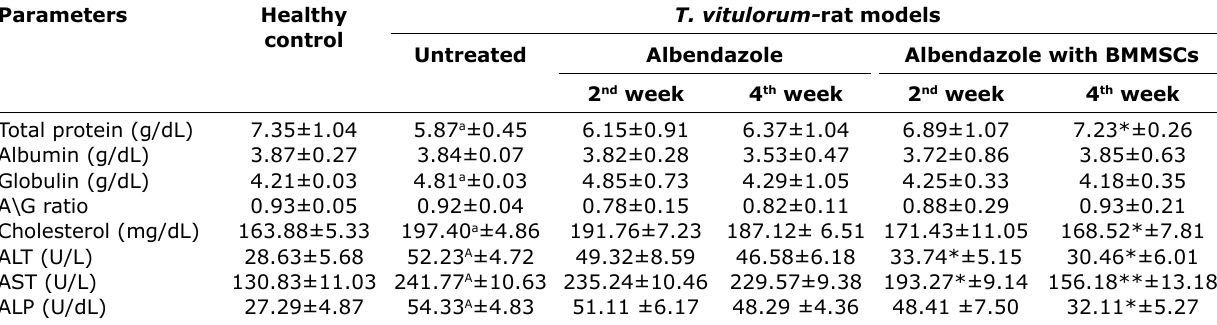
Table-4: Serum protein profile and liver enzymes activities in the serum of healthy control, treated and untreated T. vitulorum -rat models.